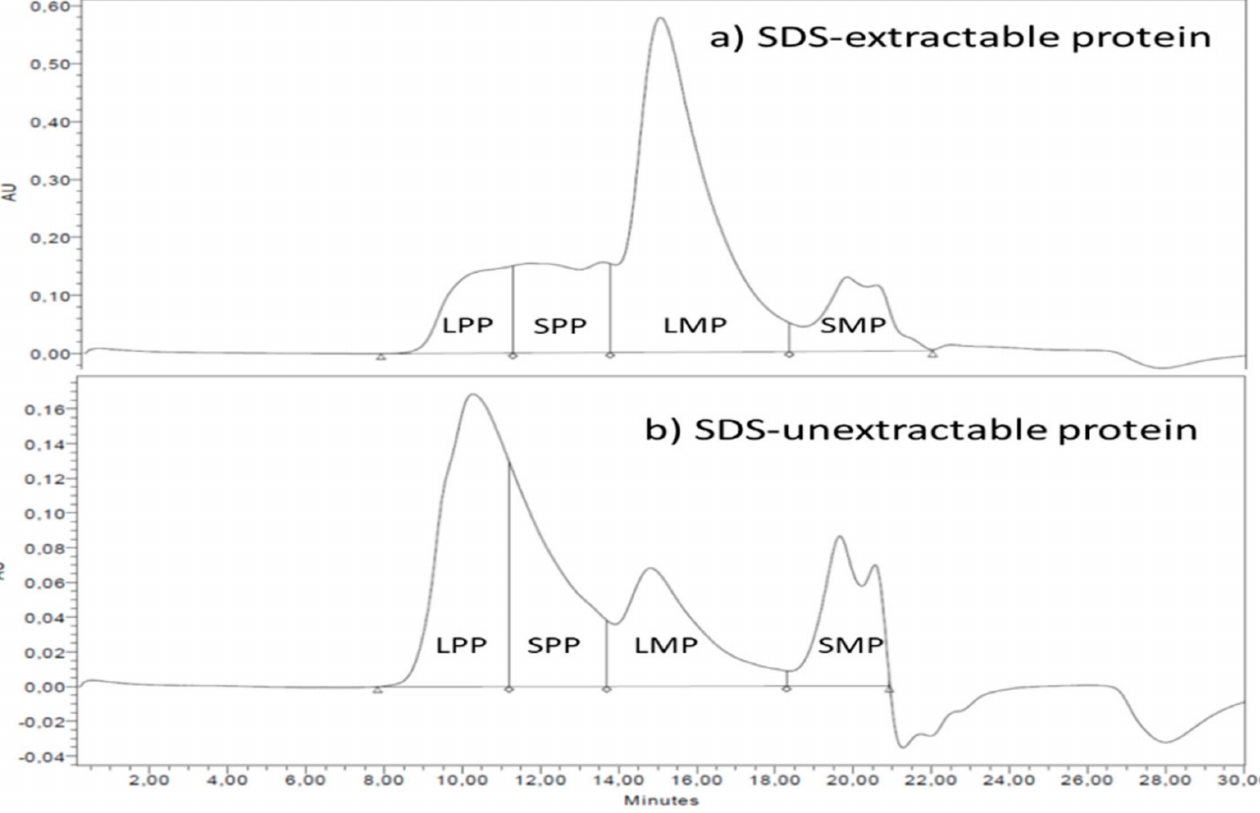
Figure 2. A representative chromatogram (from F11) showing SDS-extractable and SDS-unextractable proteins divided into the four parts containing large polymeric proteins (LPP), small polymeric proteins (SPP), large monomeric proteins (LMP) and small monomeric proteins